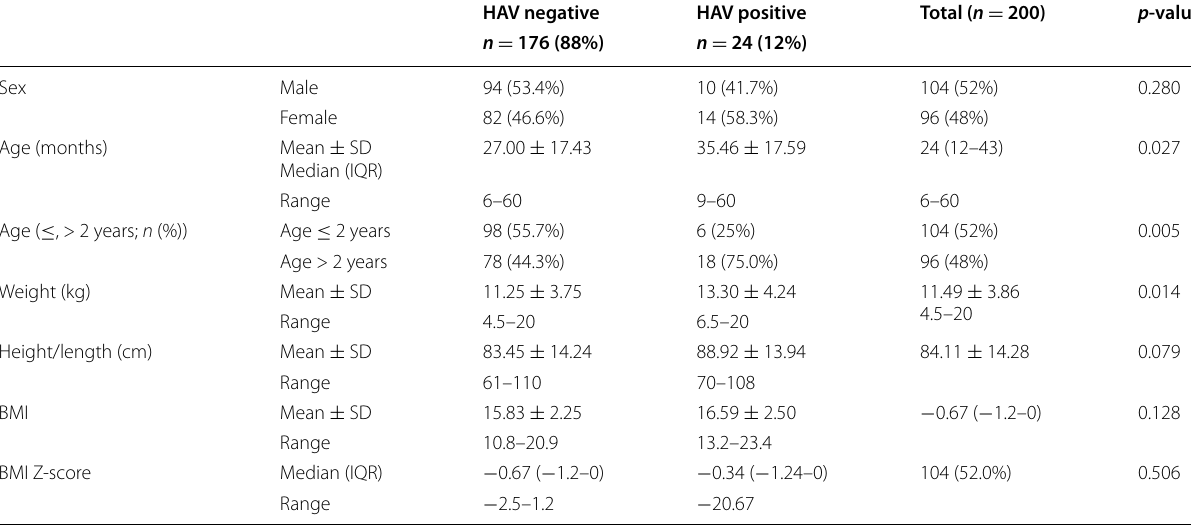
Table 1 Demographic characteristics of HAV‑negative and HAV‑positive groups